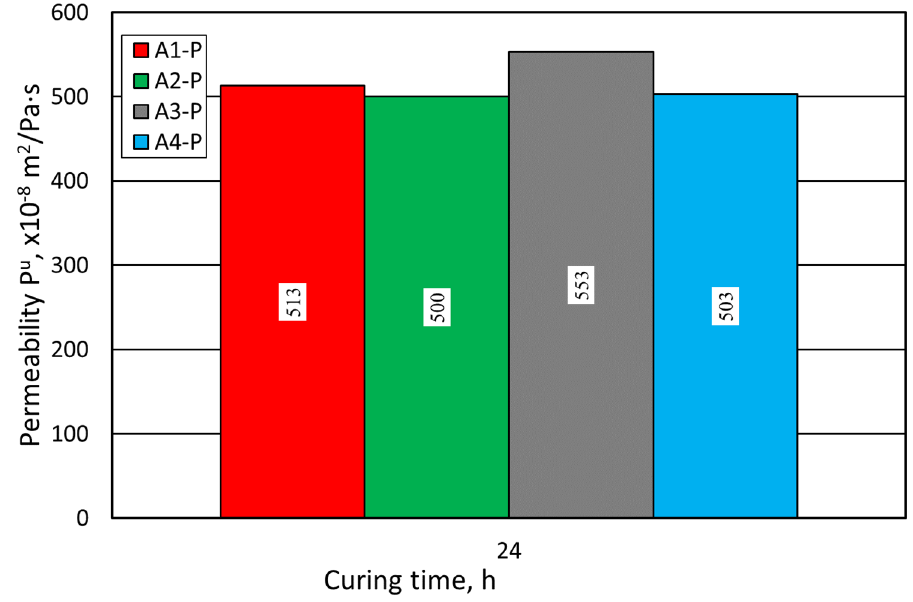
Figure 10. Molding sand P u permeability test carried out on Pioma Foundry (P) grain matrix.